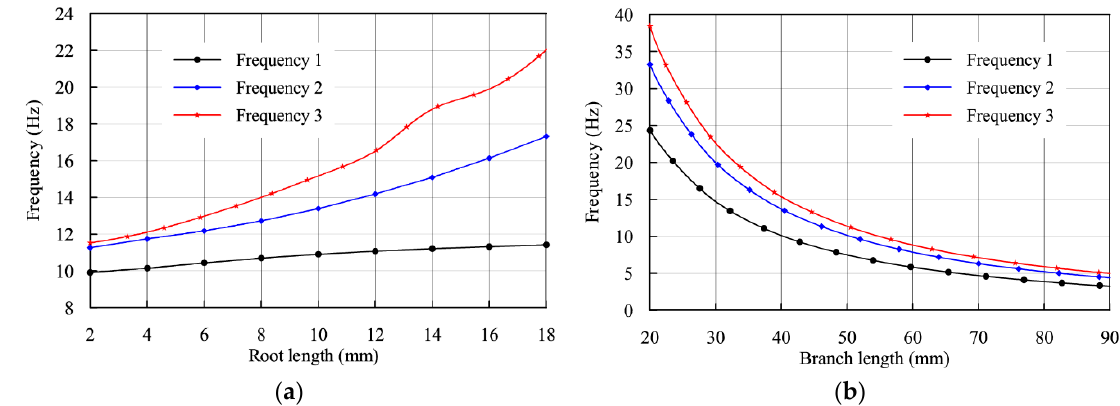
Figure 3. Effect of root length ( Lr ) and branch length ( L ) on resonant frequency: ( a ) variation of frequency with L r and ( b ) variation of frequency with L .